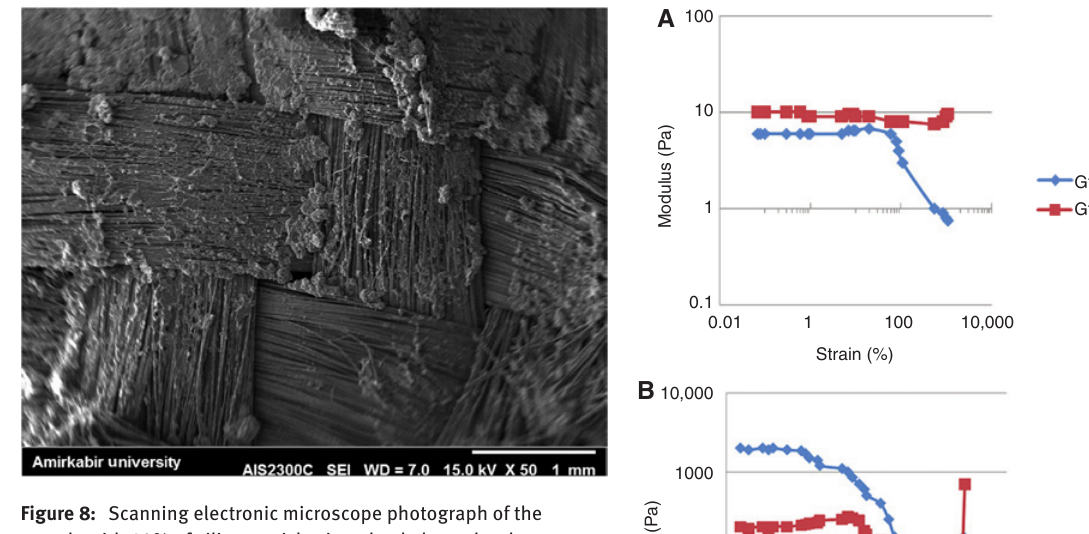
Figure 8: Scanning electronic microscope photograph of the sample with 40% of silica particles in polyethylene glycol.